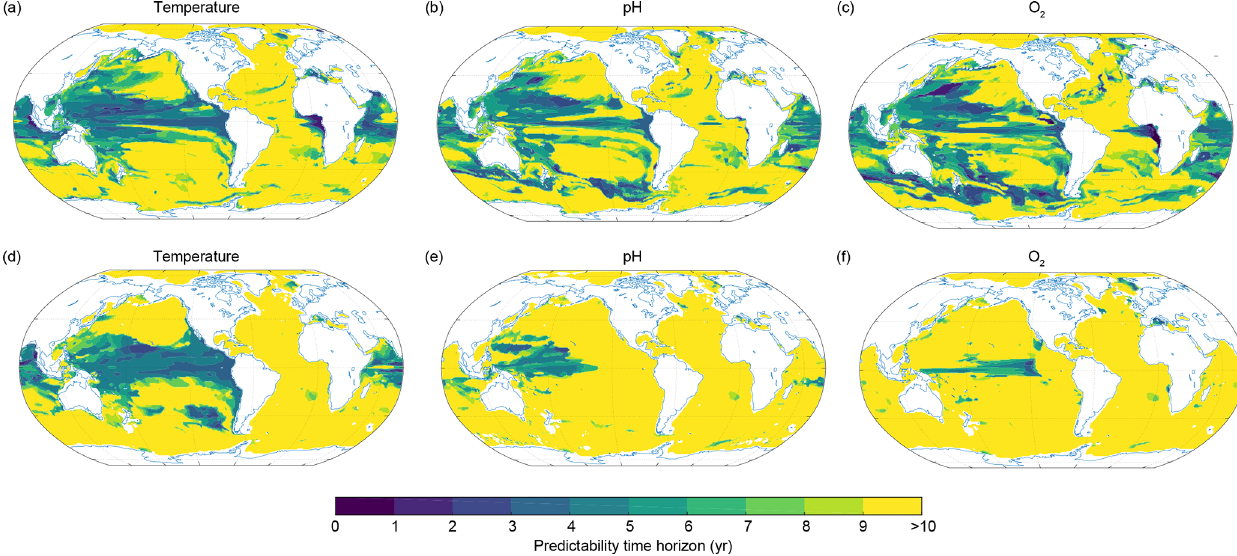
Figure 6. Spatial pattern of the predictability time horizon at (a–c) 300m and (d–f) 1000m depth for (a, d) ocean temperature, (b, e) pH and (c, f) dissolved